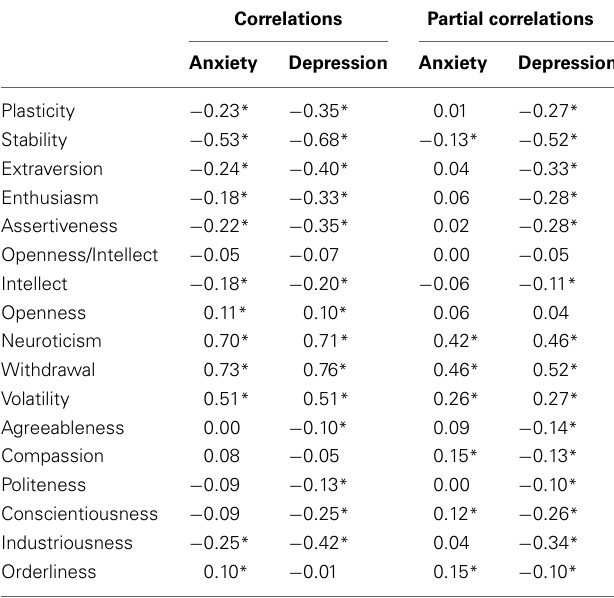
Table 1 | Associations of NEO PI-R Anxiety and Depression (Costa and McCrae, 1992b) with the Big Five aspect scales (DeYoung et al., 2007) and Plasticity and Stability scales (DeYoung, 2010c) in the Eugene-Springfield community